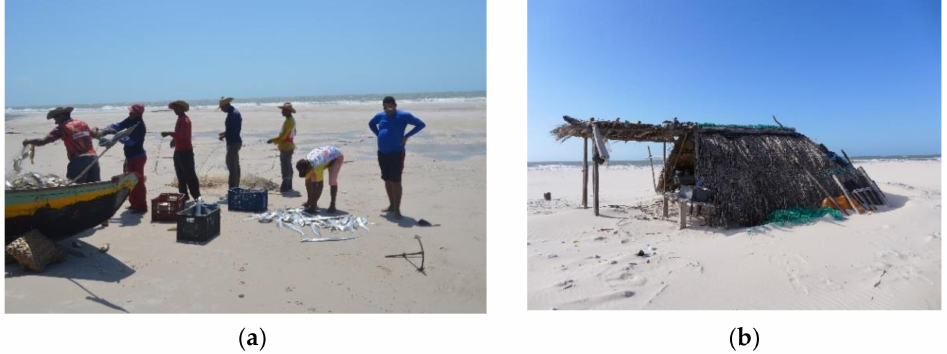
Figure 10. ( a ) Fishermen in activity at Lenç ó is Maranhenses beach; ( b ) Support ranch on Grandes Lenç ó is beach; the format, type of deck and position of the ranch considers the direction of the winds, solar incidence and thermal comfort, in an environment with temperatures above 40 ◦ C. Using their native guidance system, residents of communities far from the sea are able to travel through the dune fields and arrive precisely at certain beaches located about a 4- or 5-h walk away (Figure